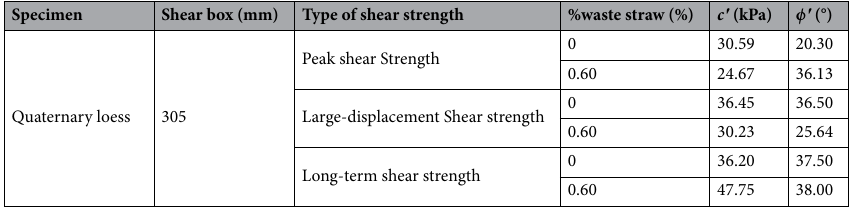
Table 3. Summary of the peak, large-displacement, and long-term shear strength